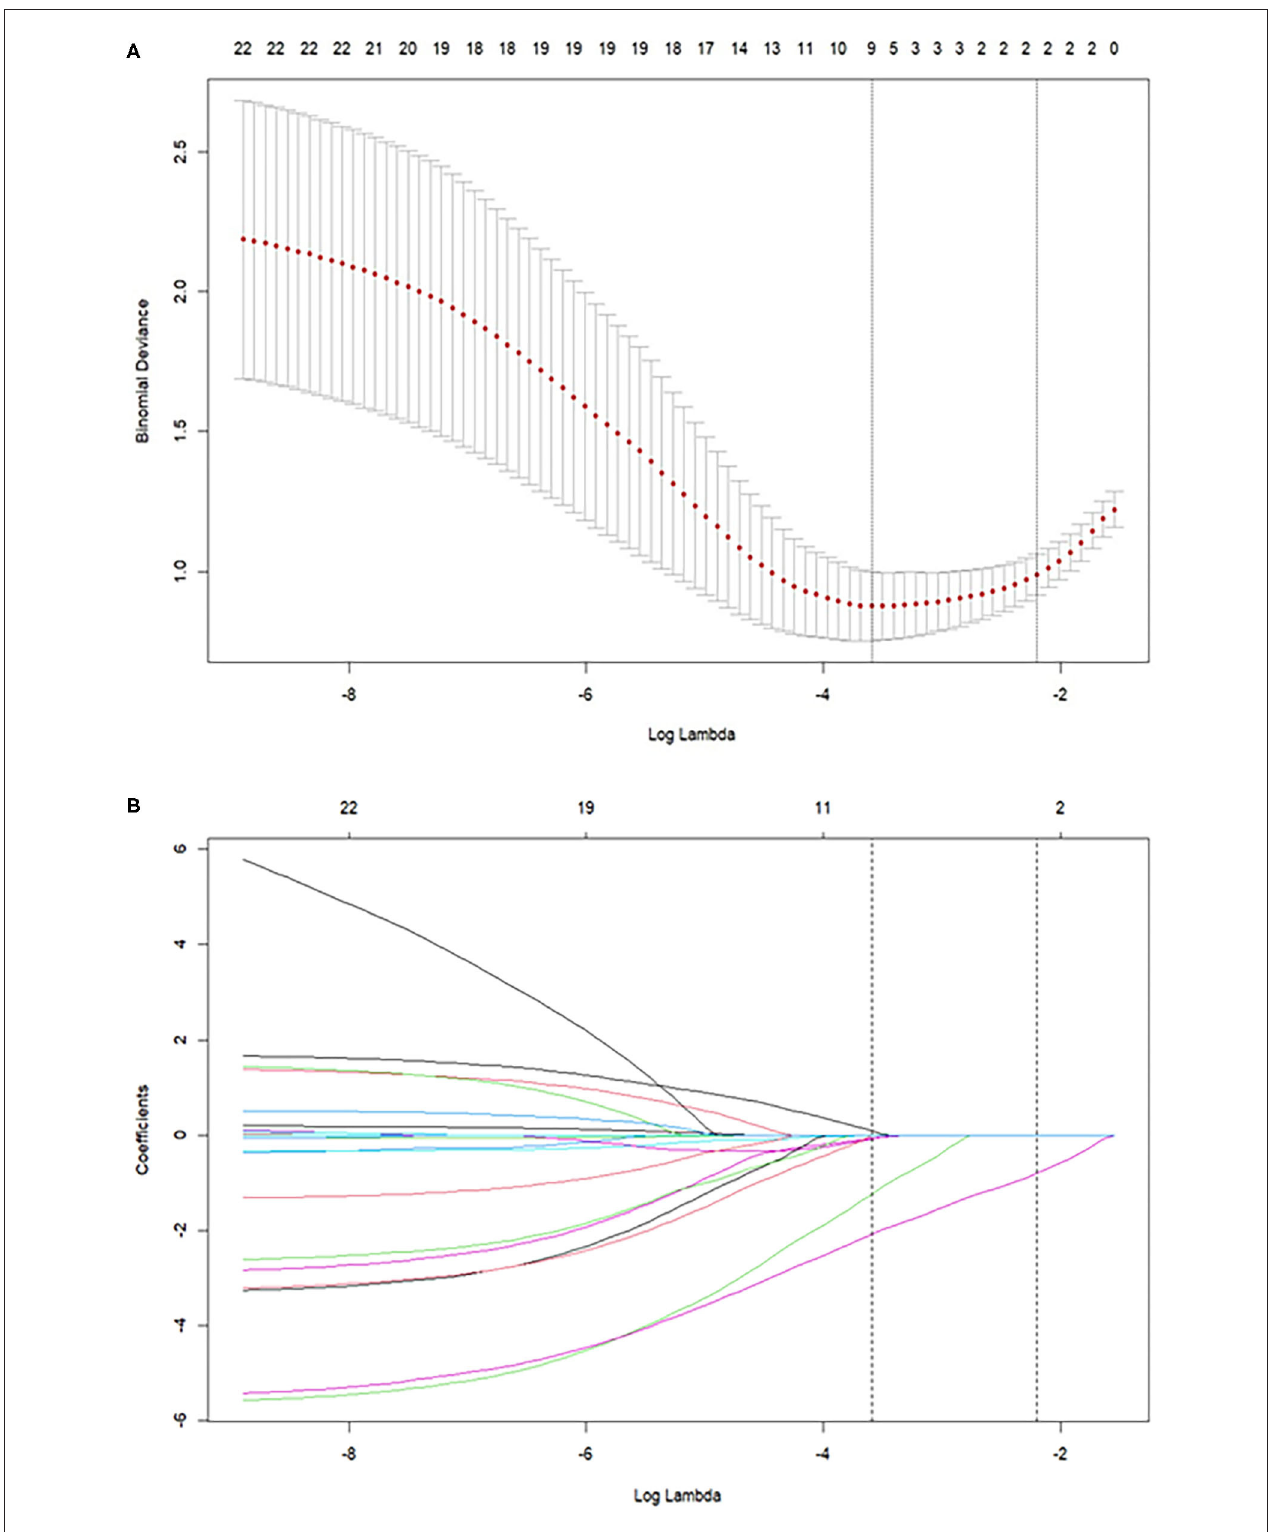
FIGURE 2 | (A) Binomial Deviance of the LASSO model with different log (lambda). (B) LASSO coefficient profiles of the risk factors predicting IUBT failure. The best combination of risk factors was selected by LASSO logistic regression analyses, with risk factors selected by the log (lambda) at which the minimal Binomial Deviance was achieved. LASSO, least absolute shrinkage and selection operator; IUBT, intrauterine balloon tamponade.